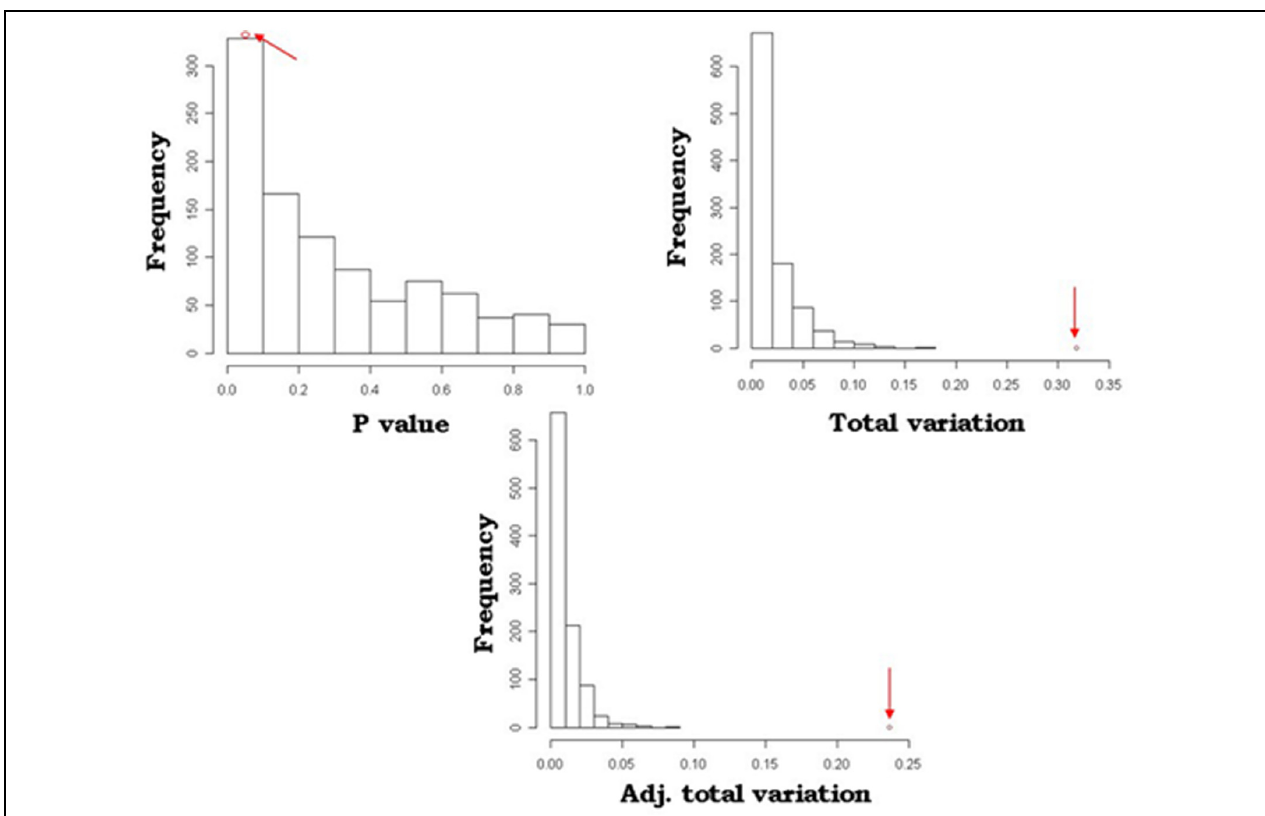
FIGURE 2 | Comparison of SOCS model and simulation outcomes for Australian Profit Ranking (APR). Distribution of P -values, total variation and adjusted total variation for the 1000 permutation calculations in the simulation model. The arrows indicate the values identified in the SOCS association